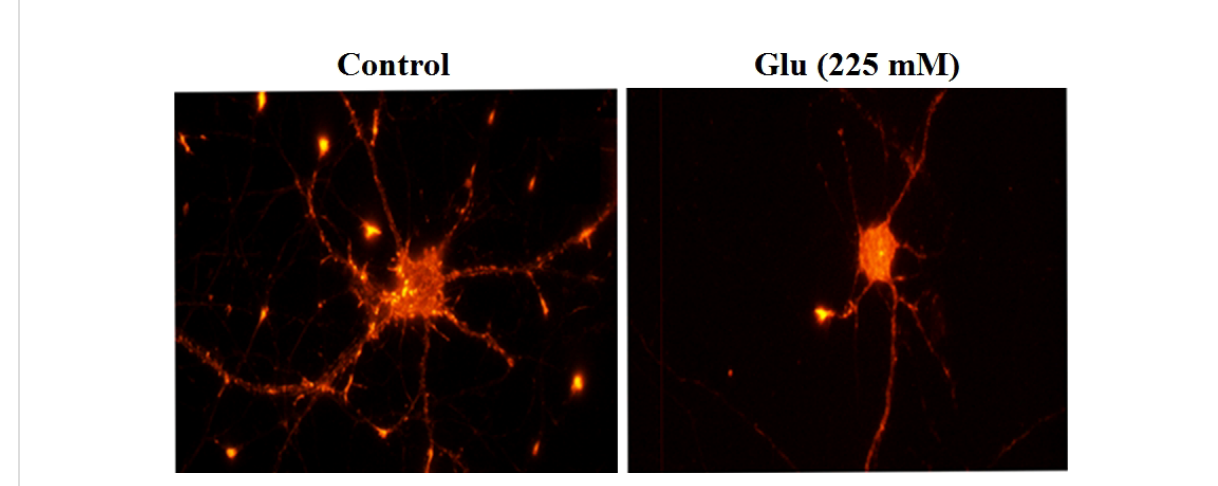
FIGURE 7 Immuno fl uorescence analysis of the morphological changes of neurite length and dendritic branching under high glucose stimulation (×400).